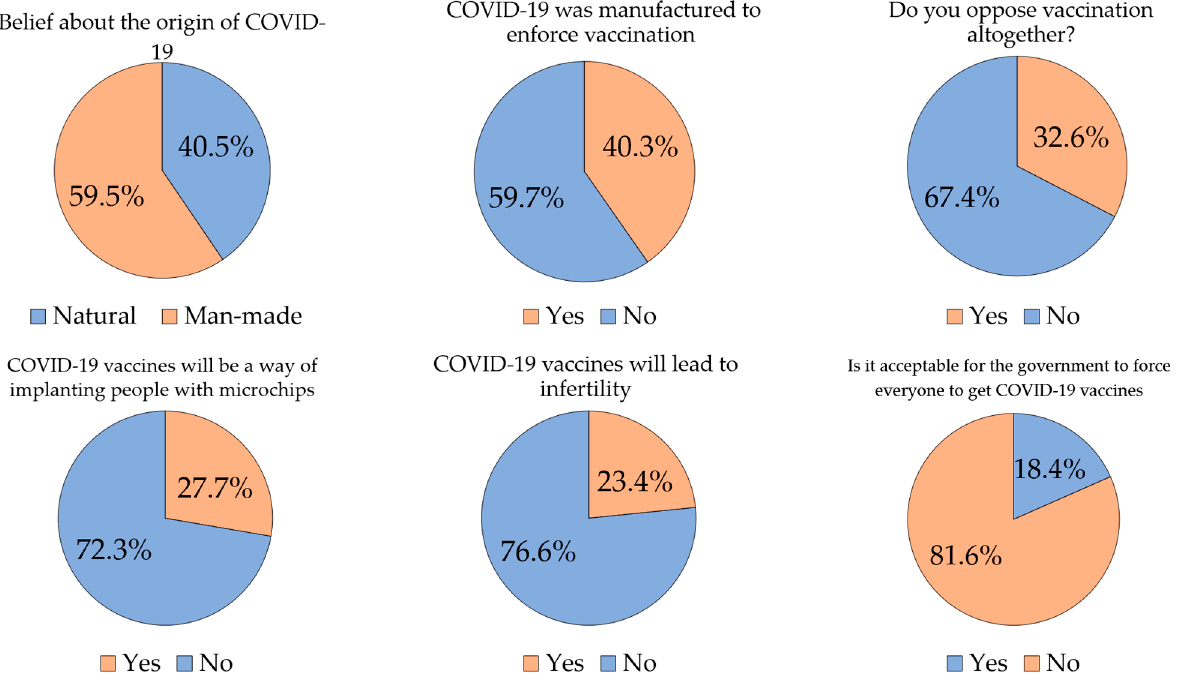
Figure 2. Attitudes to COVID-19 vaccines in relation to conspiracy beliefs and towards governmental enforcement of the vaccines. COVID-19: Coronavirus disease 2019. Table 3. Vaccine conspiracy beliefs and attitude items stratified by countries of residence.